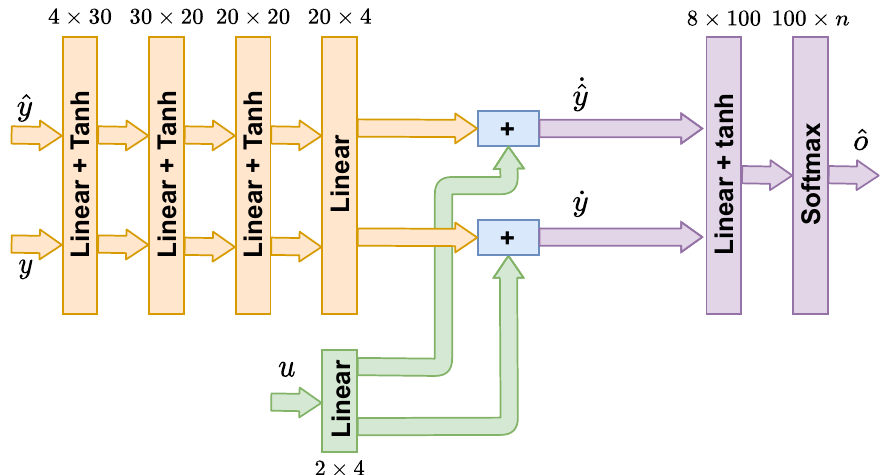
Figure 6. Neural network model for fault diagnosis training.